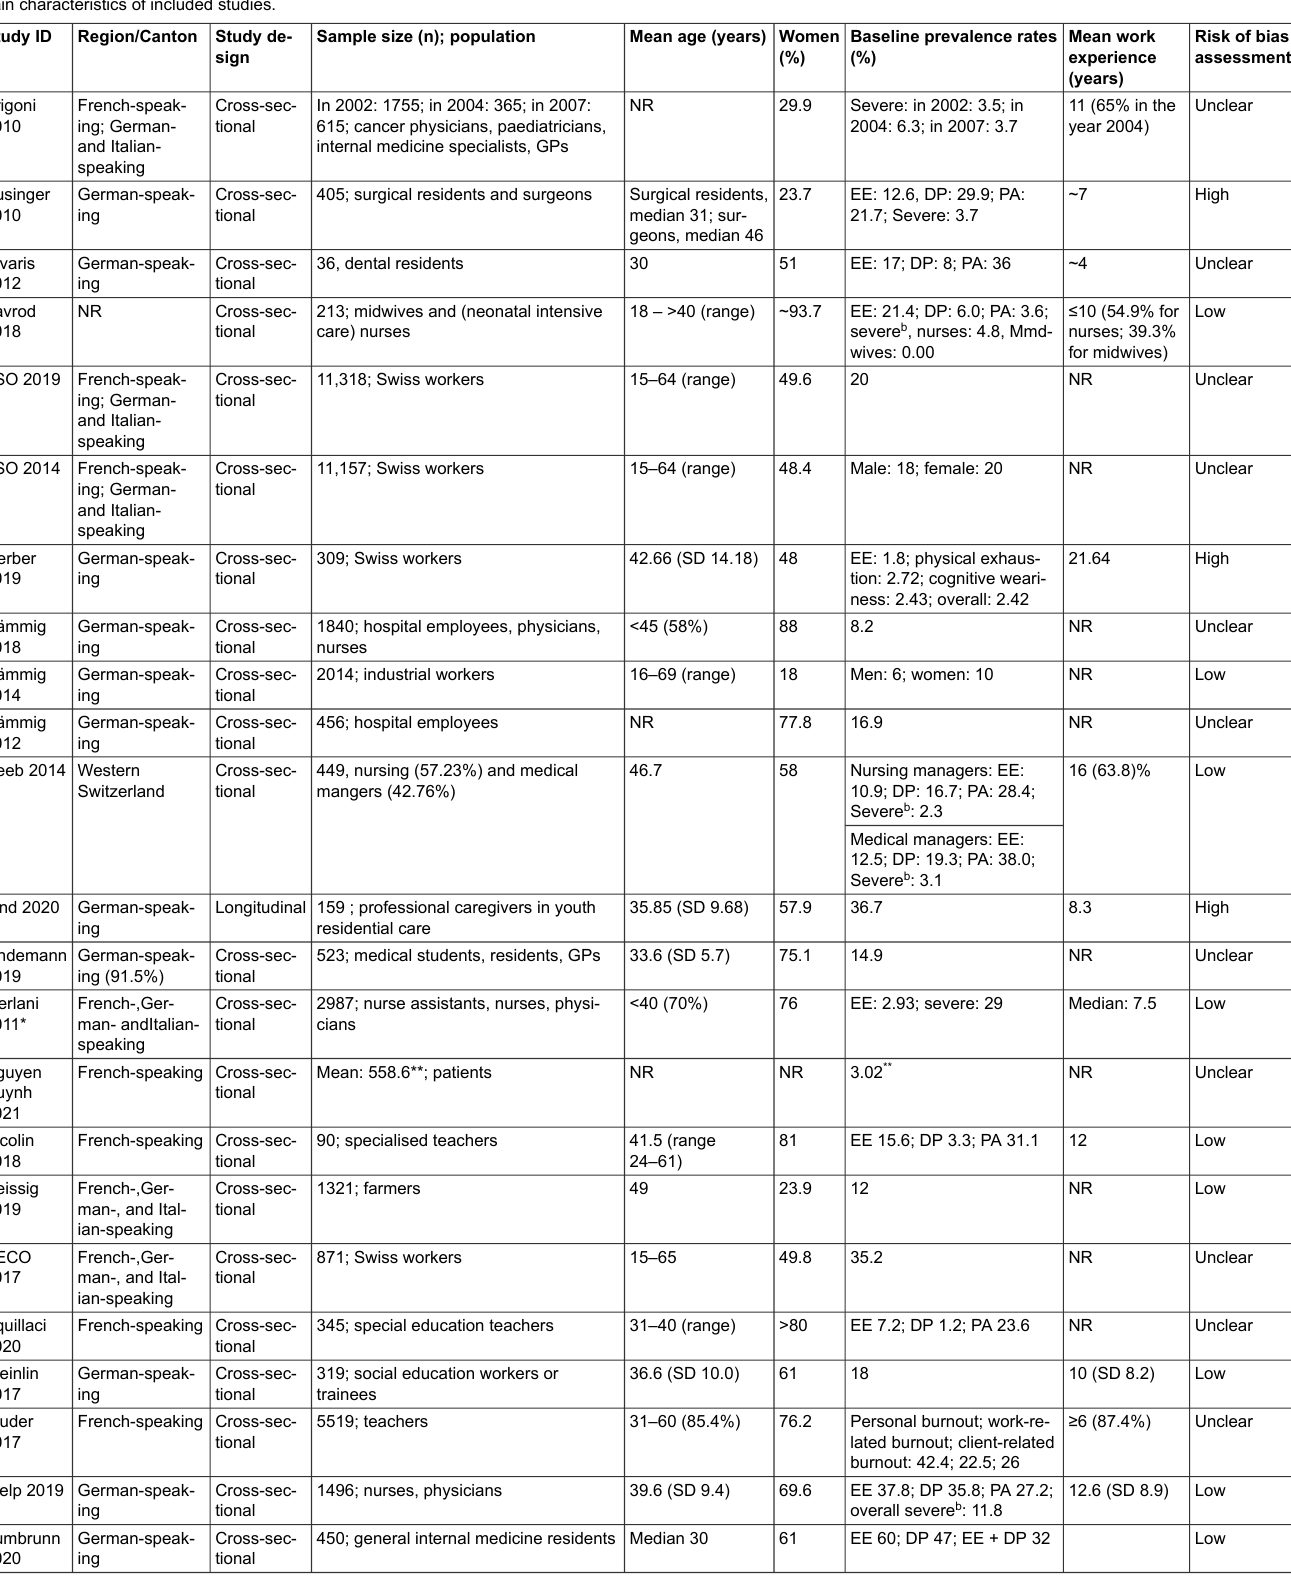
Table 1: Main characteristics of included studies. Study